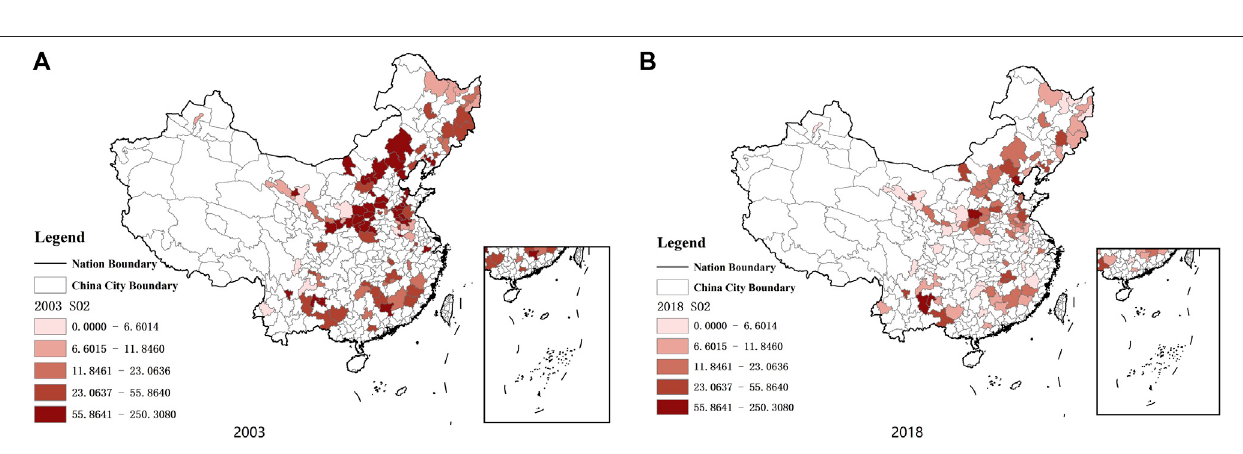
Frontiers in Environmental Science |